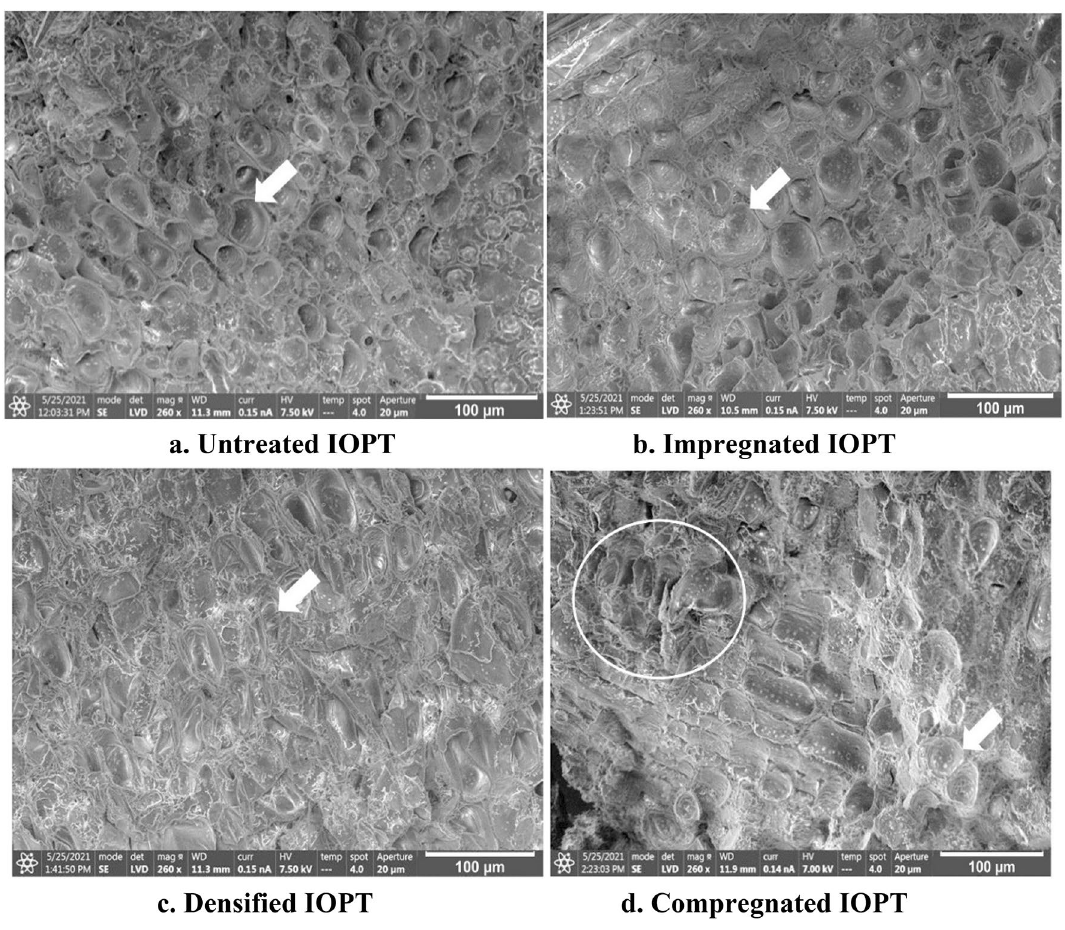
Figure 3. Scanning electron micrographs of the transverse surface in ( a ) untreated palm trunk, ( b ) impregnated inner part of oil palm trunk (IOPT), ( c ) densified IOPT, and ( d ) compregnated IOPT. ( a ) Empty parenchyma lumen in untreated IOPT (arrow); ( b ) methylene diphenyl diisocyanate (MDI)–filled parenchyma lumen in impregnated IOPT (arrow). ( c ) Deformed parenchyma lumen in densified IOPT (arrow). ( d ) Deformed parenchyma lumen (circle) and MDI-filled parenchyma lumen (arrow) in the compregnated IOPT. Scale bars: 100